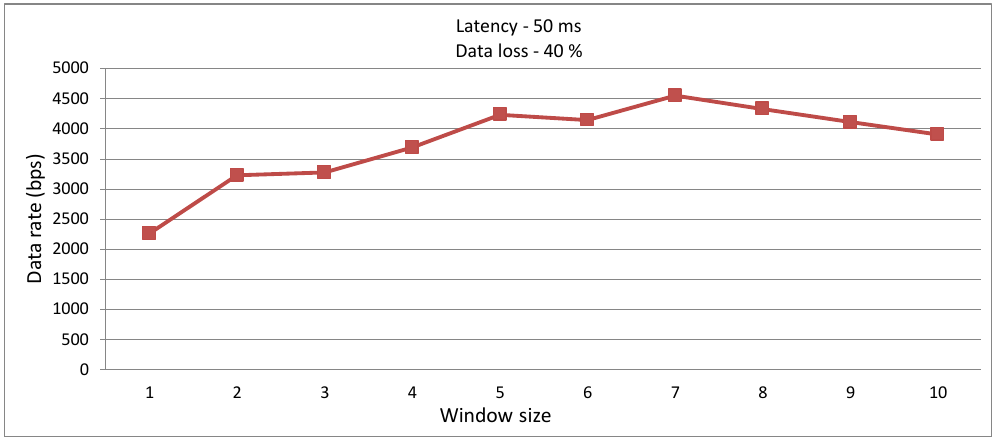
Figure 11. Data rate in the communication between the Sink and MDC, in a link with 40% loss probability and 50 ms network latency.